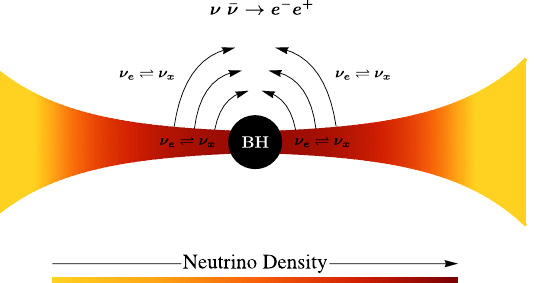
Figure 1. Schematic representation of the physical system. Due to conditions of high temperature and density, neutrinos are produced in copious amounts inside the disk. Since they have very low cross-sectional areas, neutrinos are free to escape but not before experiencing collective effects due to the several oscillation potentials. The energy deposition rate of the process ν + ¯ ν → e − + e + depends on the local distribution of electronic and non-electronic (anti)neutrinos, which is affected by the flavor oscillation